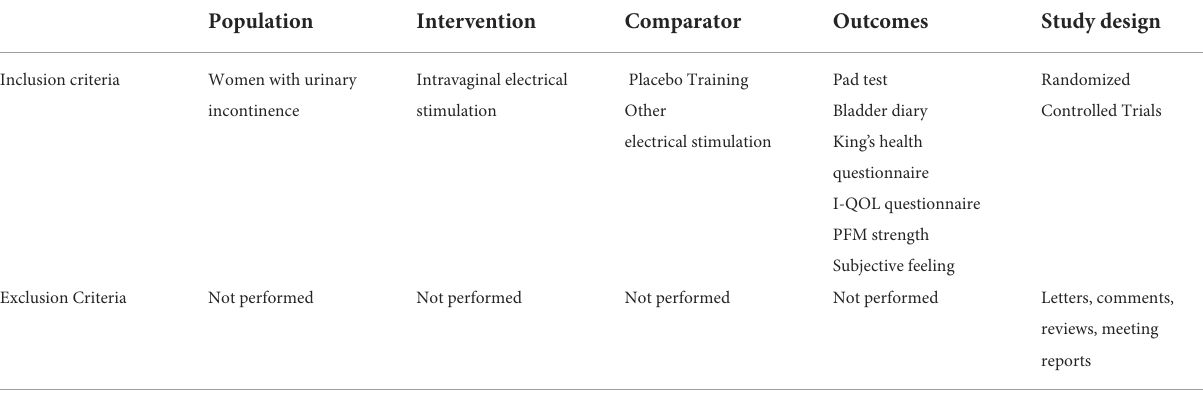
TABLE 1 Search strategy according to populations, interventions, comparators, outcomes, and study designs (PICOS). Population Intervention